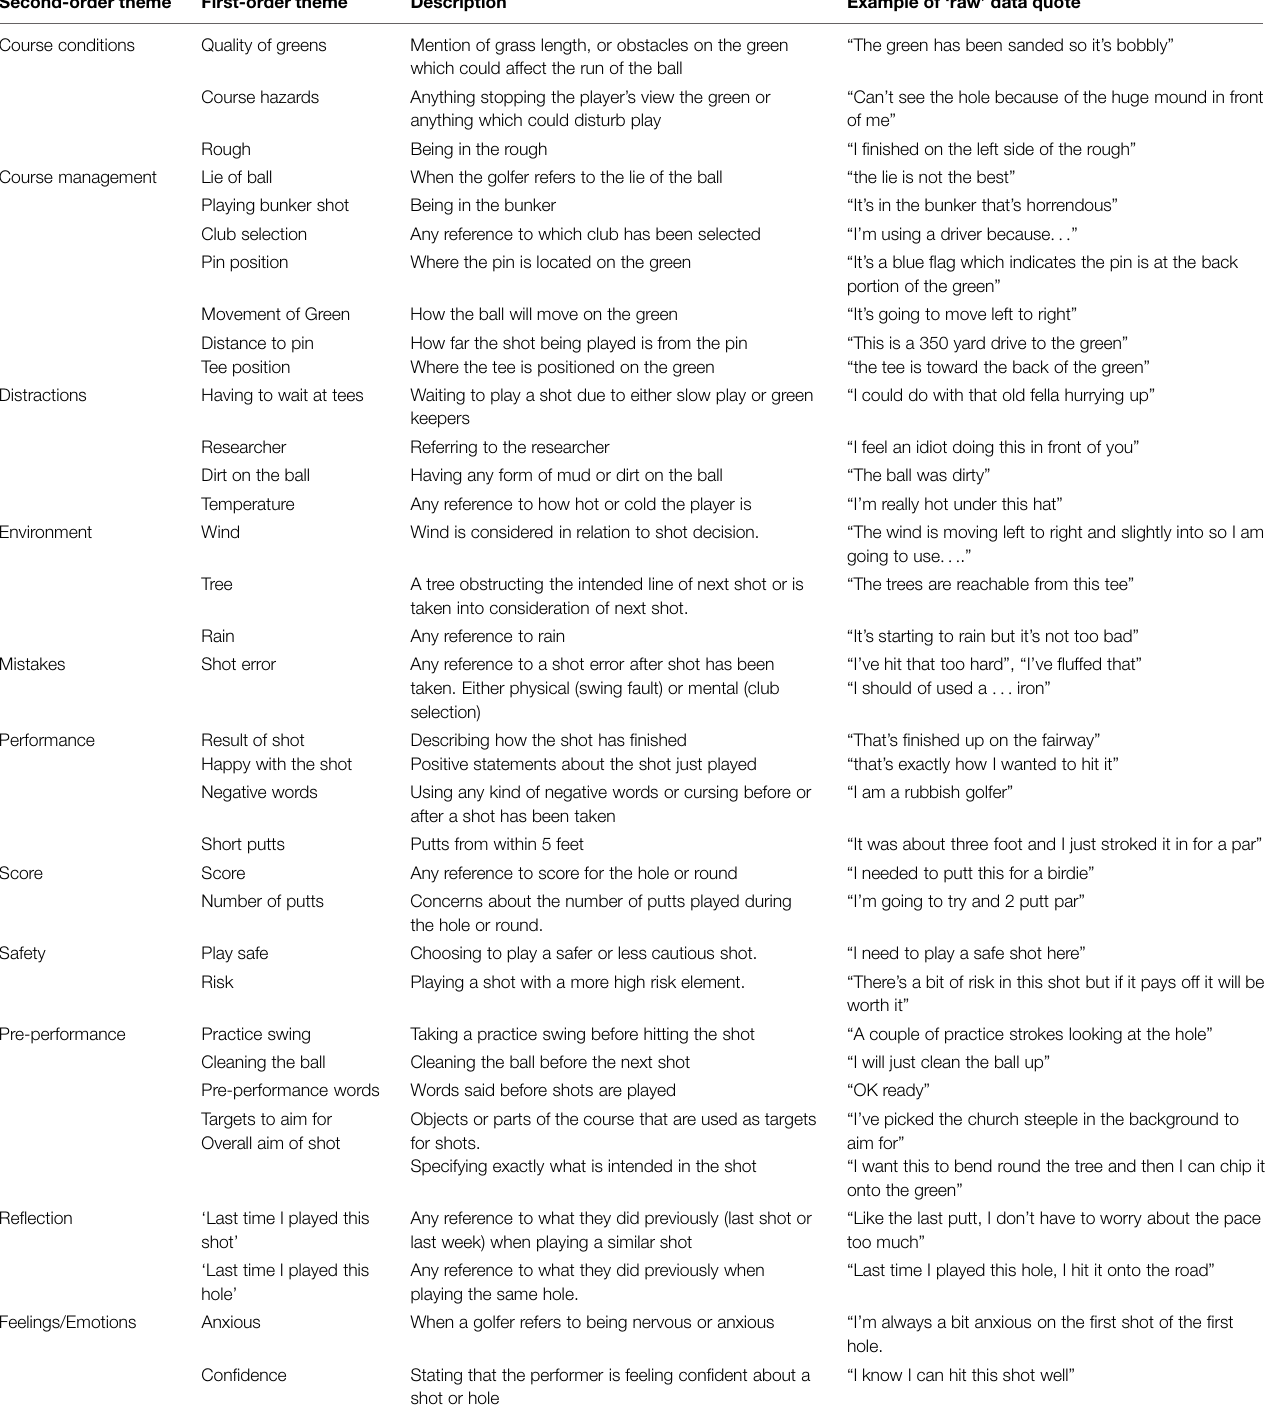
TABLE 5 | First and second-order themes identified from Think Aloud (TA) and interview